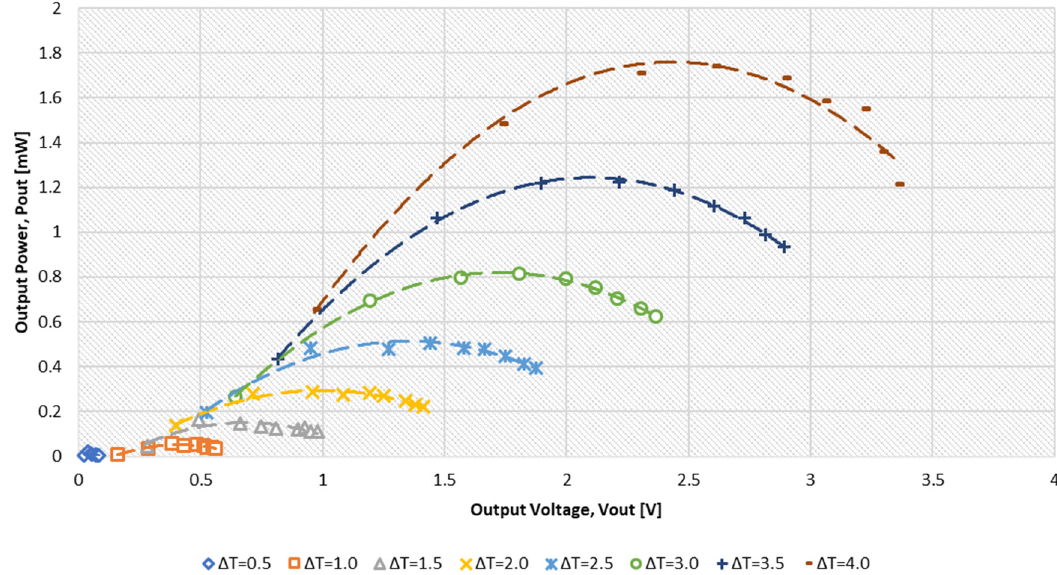
Figure 10. Thermal EHC Output Power–Output Voltage curve at 3.3 V.